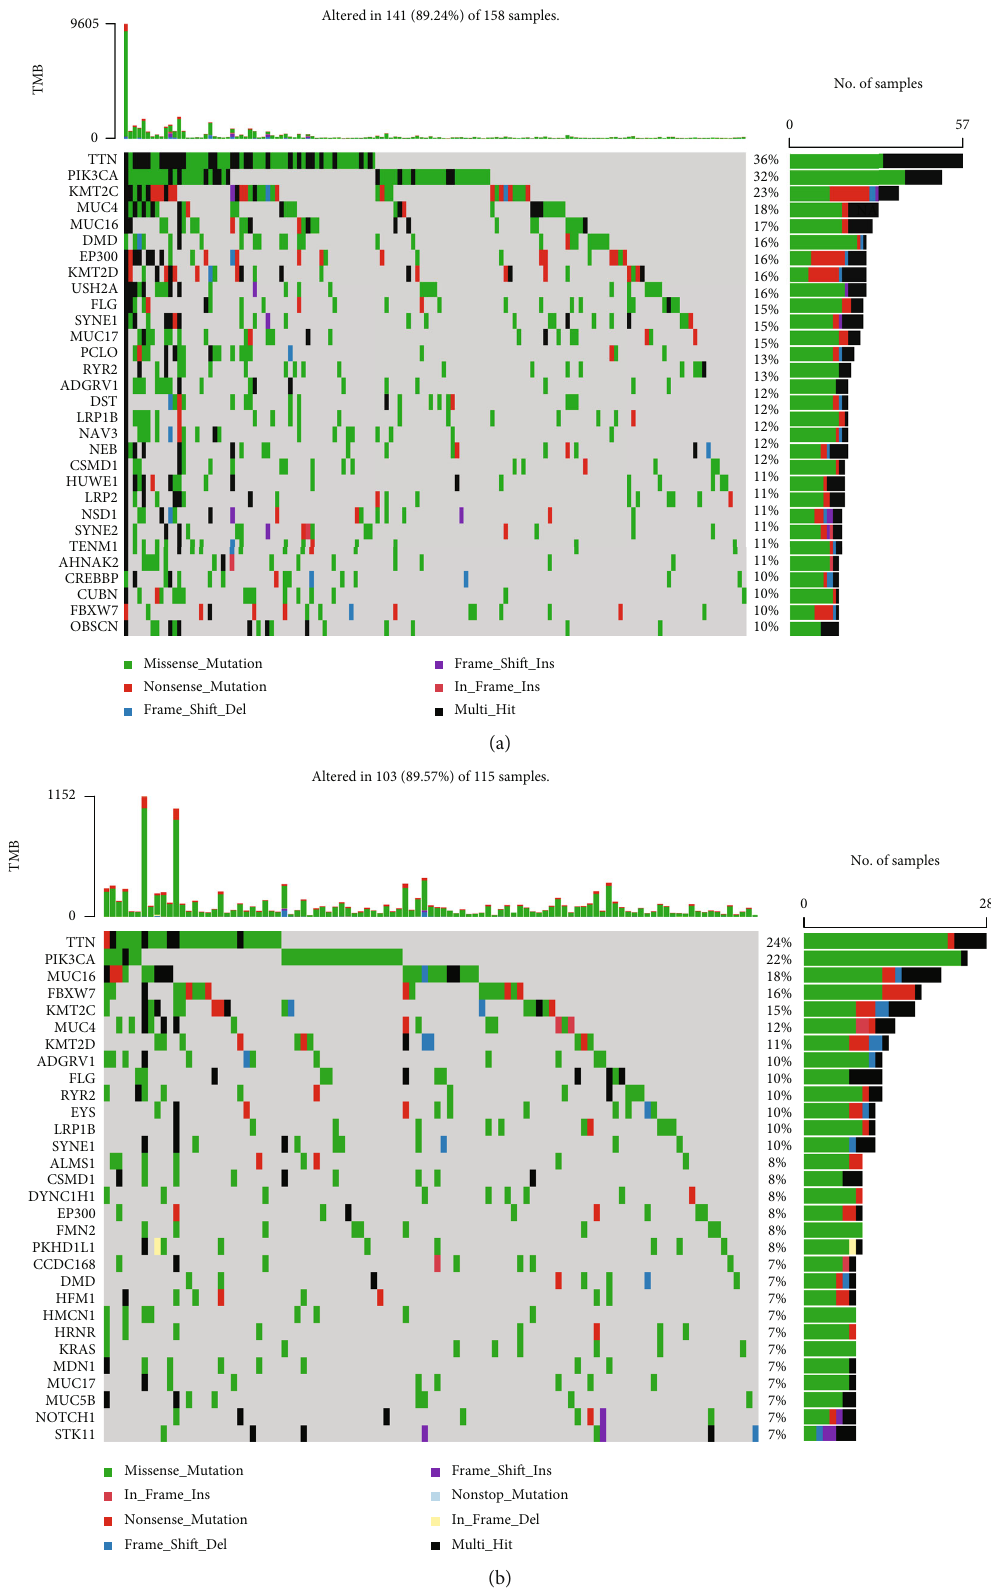
Figure 10: TMB. (a) Waterfall plot of somatic mutation status in high-risk samples. (b) Waterfall plot of somatic mutation status in a low-risk